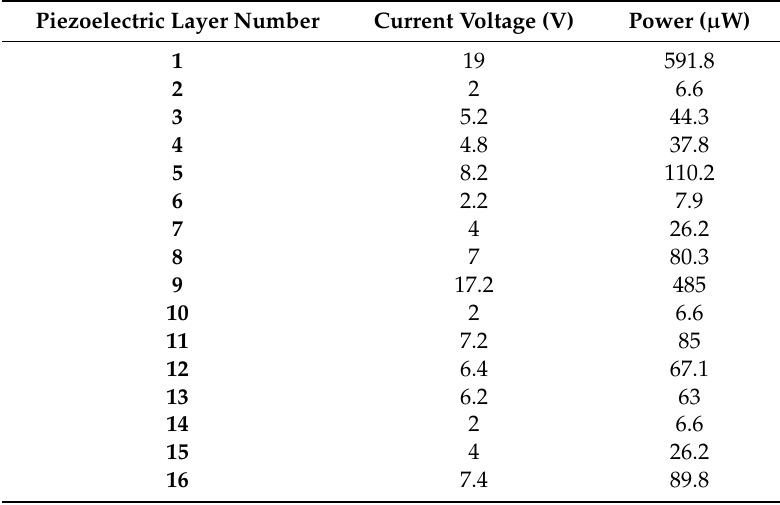
Table 2. The peak power of all 16 piezoelectric layers.